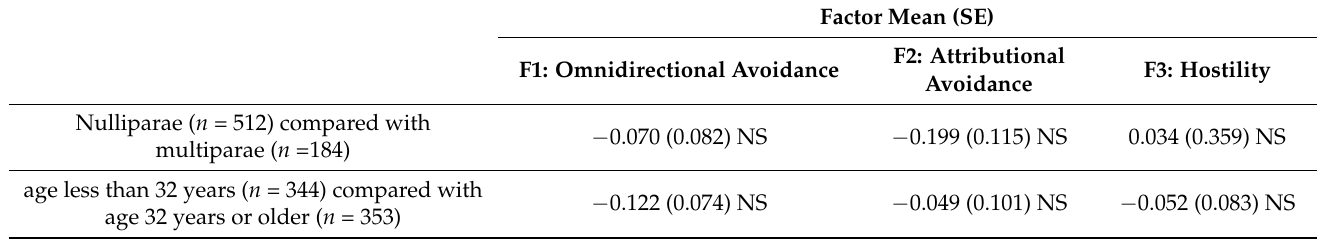
Table 7. Factor mean of the 3-factor